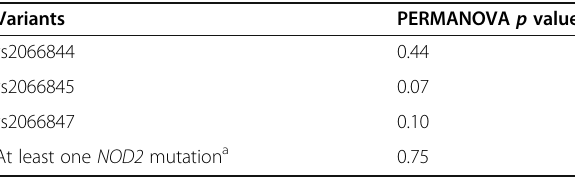
Table 2 Association between the three NOD2 polymorphisms and the clustering patterns of the fecal microbiome